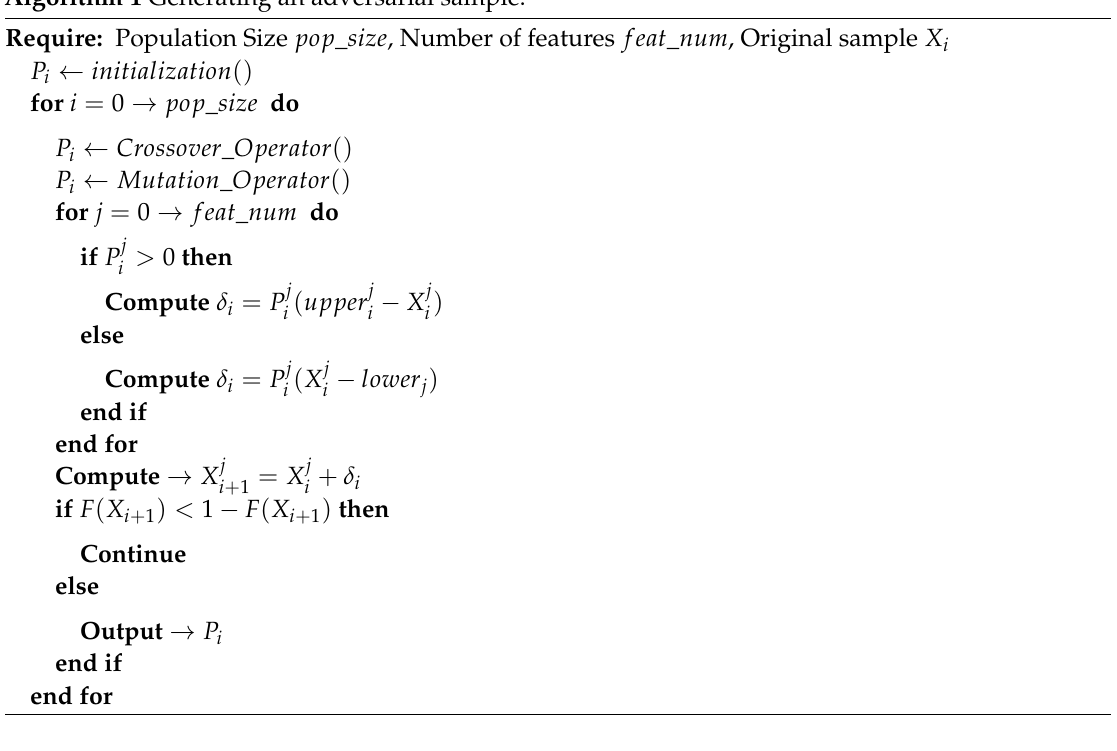
Algorithm 1 Generating an adversarial